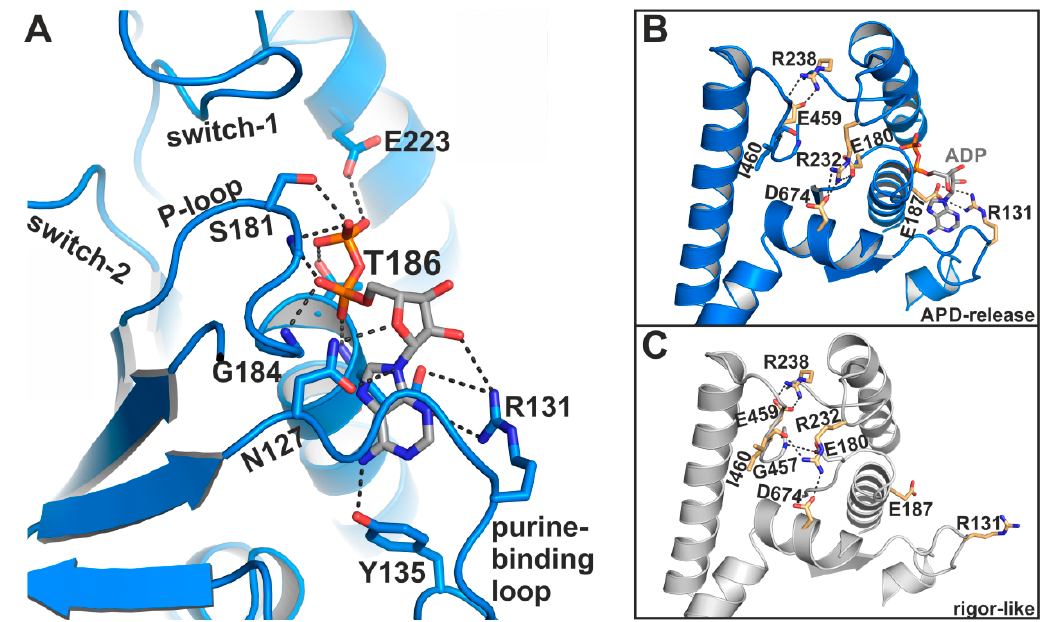
Figure 4. The myosin-II · ADP · blebbistatin crystal structure shows unique conformational features in the active site. ( A ) ADP interacts with its phosphate groups, primarily with the reoriented P-loop. The β -phosphate is partially unbound and oriented towards the surrounding water at the protein surface. The adenosine base of the nucleotide is nestled into a groove, formed by a salt-bridge between Arg131 and Glu187. ( B ) Close-up view on the active site in the myosin-II · ADP · blebbistatin structure shows the critical salt-bridge between switch-1 (Arg238) and switch-2 (Glu459), as well as the newly identified salt-bridge between Arg131 and Glu187 that stabilizes ADP in the release position. A third, complex salt-bridge between Arg232 (switch-1), Asp674 (SH2-helix), and Glu180 (P-loop) seems to be important for mediating the chemomechanical coupling between the active site, the actin-binding region and the mechanical converter / lever arm. ( C ) Close-up view on the active site in the rigor-like, nucleotide-free myosin-II structure. Due to slight adjustments to the active site, the interaction network around Arg232 is altered as compared to the myosin-II · ADP · blebbistatin structure, and Arg232 interacts with Asp674 (SH2-helix), and Ile460 (switch-2), while Glu180 (P-loop) formed a hydrogen-bond to Gly457 (switch-2) in this